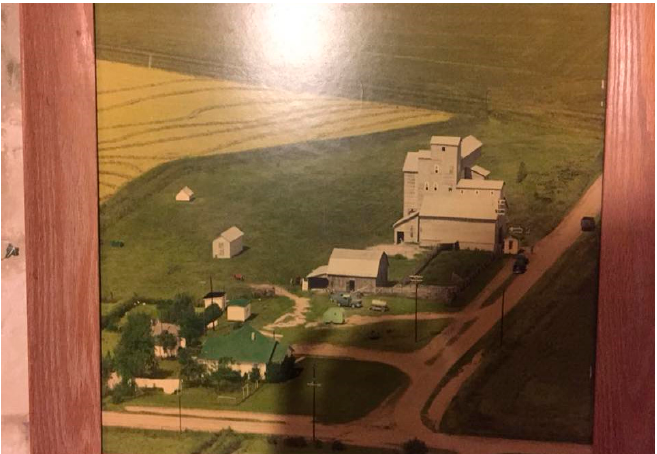
Figure 1. The Goodwin-Bauman Family Farm.